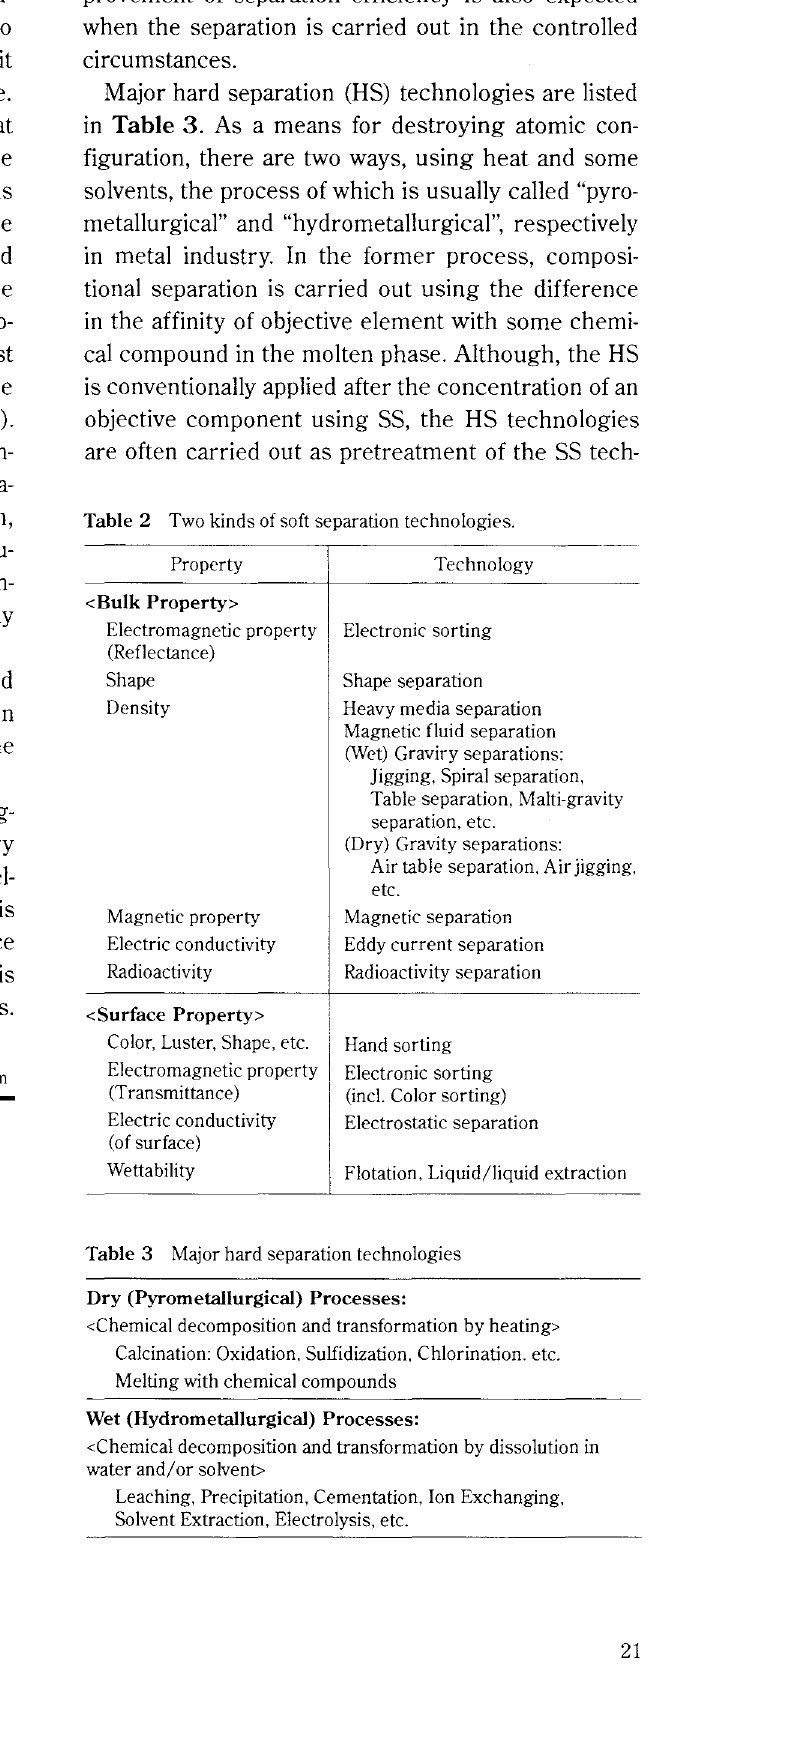
Fig. 2 Optimum size ranges for various soft separation technologies.